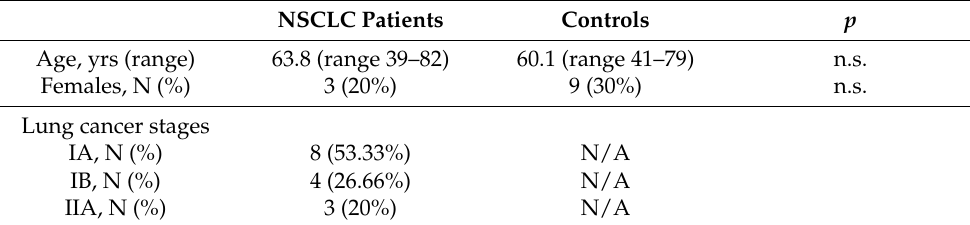
Table 1. Baseline characteristics of the enrolled